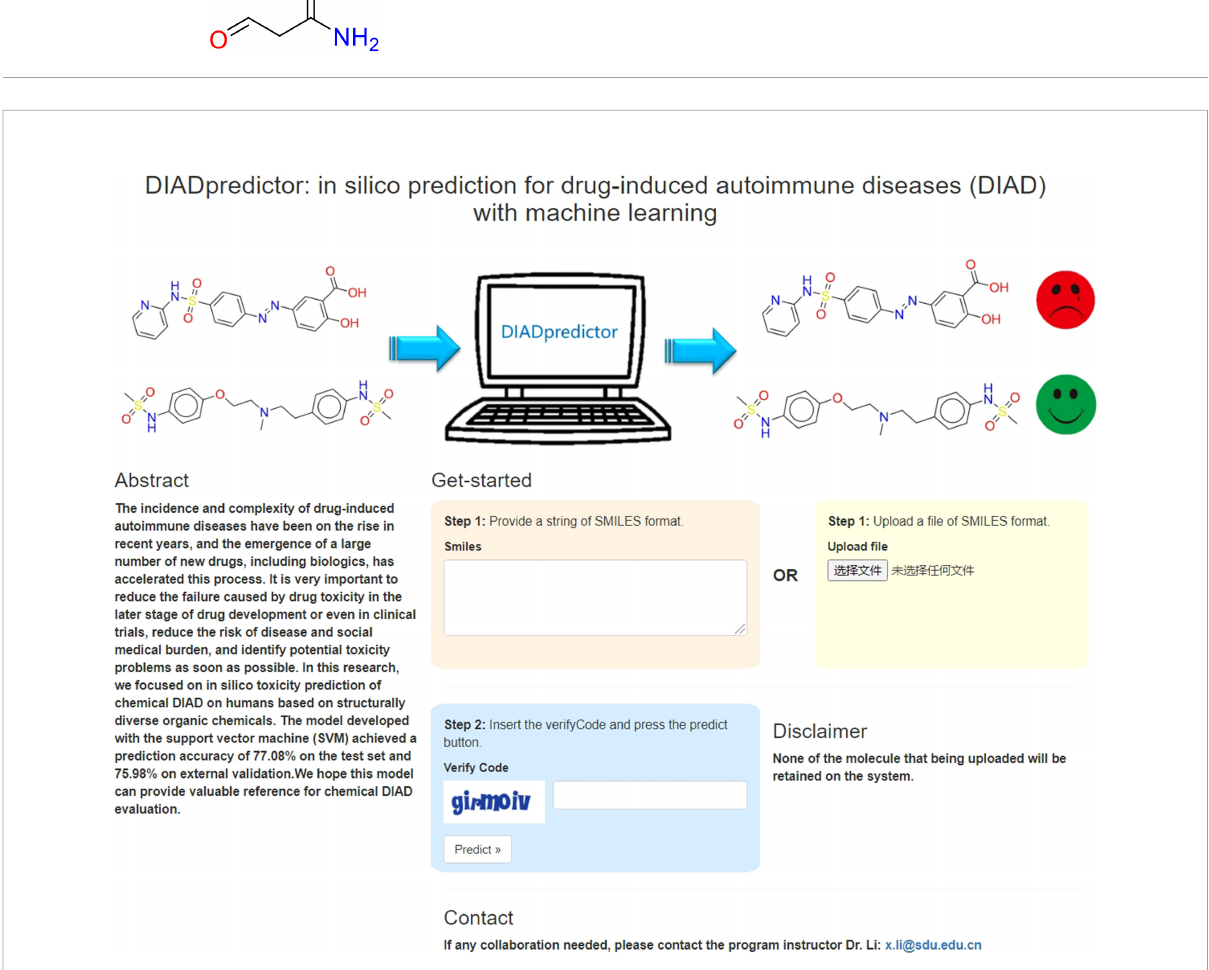
FIGURE 4 Main page of DIAD predictor web server. From this page, users can submit the query